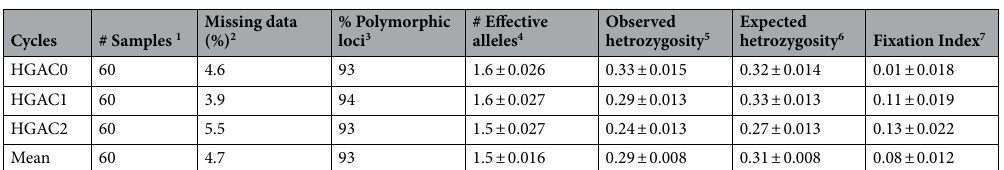
Table 4. Genetic variability based on SNP markers computed for HGA and its selection cycles. 1 # Number of samples correspond to number of plants from which leaf tissue was assayed. 2 Percent (%) of missing data is the percentage of markers that did not return data computed per cycle. 3 Percent of polymorphic loci is the percentage of polymorphic loci to the total number of loci (polymorphic and monomorphic) per cycle. 4 Number of effective alleles are the number of alleles that can be present in the population. 5 Observed heterozygosity is the number of markers within a population that are heterozygous calculated per cycle based. 6 Expected heterozygosity is the probability that at a single locus, any two alleles chosen at random from the population are different to each other. 7 Fixation index is the measure of reduction in heterozygosity.